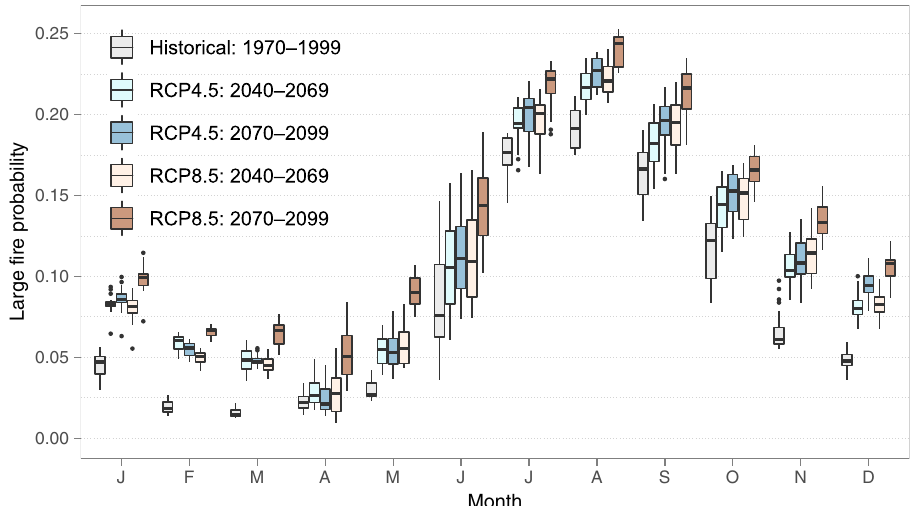
Fig. 3 Seasonal variations in the earth system model (ESM) ensemble-mean large fi re probability (LFP). Monthly LFPs for the end of the 20th century (grey, 1970 – 1999), and the middle (light blue and light tan, 2040 – 2069) and end (blue and tan, 2070 – 2099) of the 21 st century in the coastal southern California area (CSCA) are shown. LFP simulations for the moderate (RCP4.5, blue) and high (RCP8.5, tan) emission climate change scenarios are compared here. Meaning of boxplot elements: central line: median, box limits: upper and lower quartiles, upper whisker: min(max(x), Q3 + 1.5 × IQR), lower whisker: max(min(x), Q1 − 1.5 × IQR), black dots: